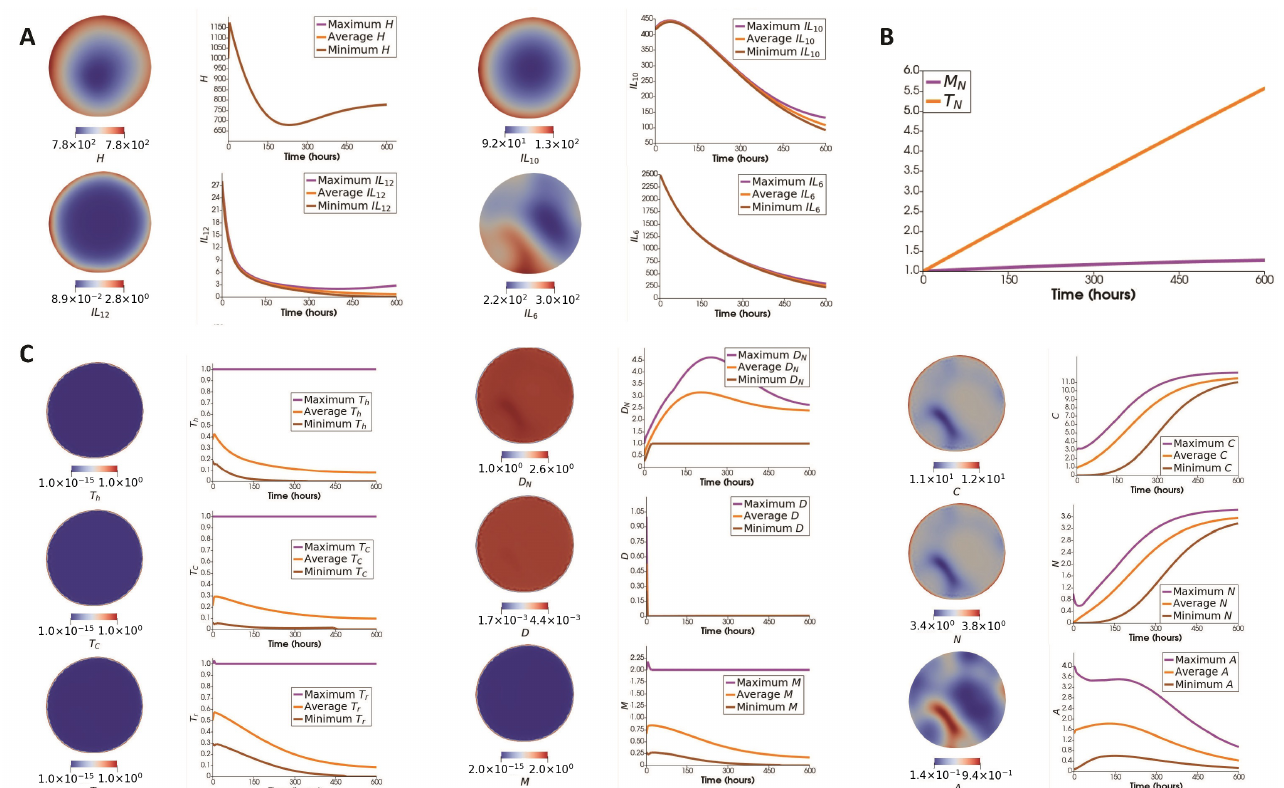
Figure 9. Results with flux of immune cells. ( A ) Column 1 : Spatial distribution of cytokines. Column 2 : Maximum, average, and minimum concentration (ng/mL) of each cytokine over the whole domain with respect to time. ( B ) Evolution of naive T cells and naive macrophages. ( C ) Column 1 : Spatial distribution of cell types. Column 2 : Maximum, average, and minimum number of each cell type over the whole domain with respect to time.